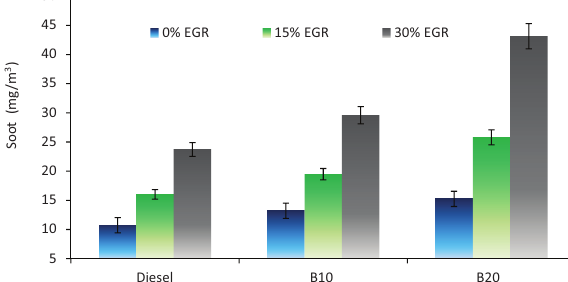
Figure 9. Effect of alcohol blends and different EGR rates on soot emissions under 1800 rpm